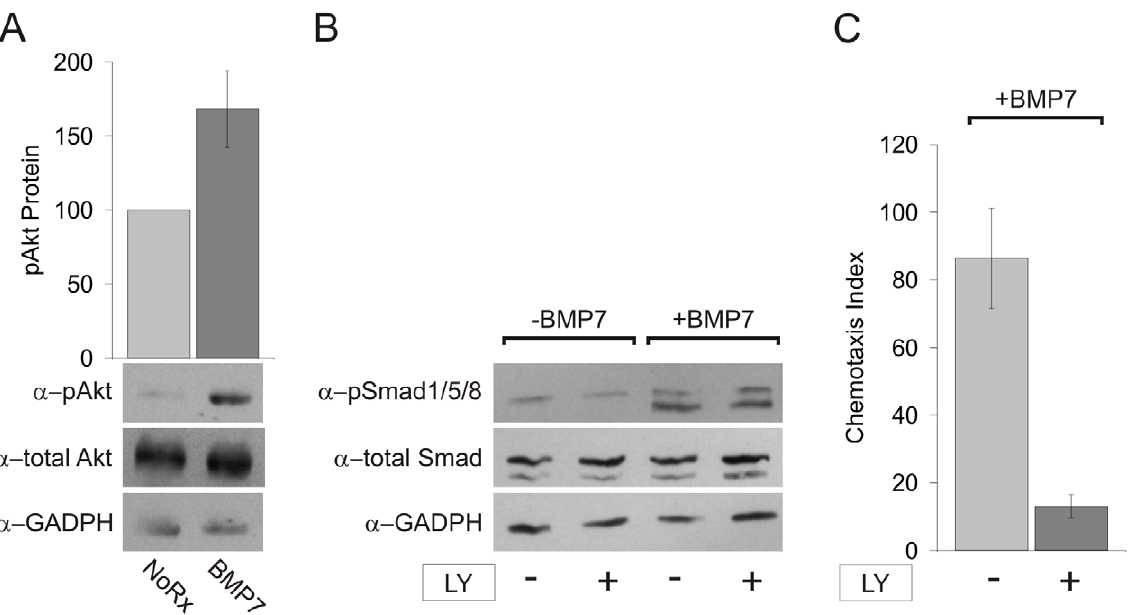
Figure 7. PI3K activity is stimulated by BMP7 and required for BMP7-evoked chemotaxis. A: Western blots of whole cell lysates of WEHI 274.1 cells incubated with or without 50 ng/ml BMP7 were probed with a phospho-specific a -Akt(S) antibody. Measurement of total Akt and GAPDH provided loading controls. Densitometric measurement (mean + / 2 SEM) shows an increase in response to BMP7 (70% over control n=2). B: Western blots of whole cell lysates of control and 50 m M LY-treated WEHI 274.1 cells incubated with or without 50 ng/ml BMP7 were probed with a phospho- specific a -Smad1/5/8 antibody. Measurement of total Smad and GAPDH provided loading controls. Inhibition of PI3K activity did not affect BMP7- evoked stimulation of R-Smad phosphorylation. C: Chemotaxis (mean + / 2 SEM) of WEHI 274.1 cells in response to 10 pg/ml BMP7 was significantly reduced following 50 m M LY294002 (LY) treatment (85% reduction). BMP7-LY (CI=86 + / 2 15, n=3) v. BMP7 + LY (CI=13 + / 2 3.5, n=3), p=0.0086 (Student’s t test). Treatment with LY alone had no effect on WEHI 274.1 cell movement under control conditions (LY alone: CI=3.5 + / 2 2.5, n=2; J. C. Perron and J. Dodd, unpublished).